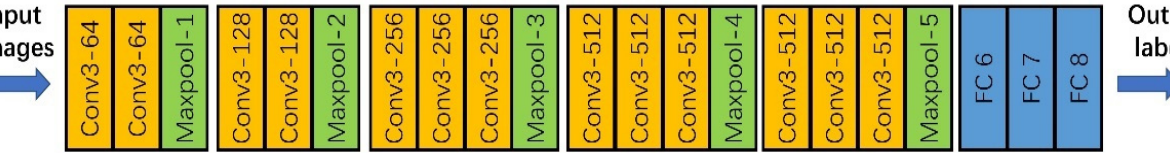
Figure 7. Structure diagram of